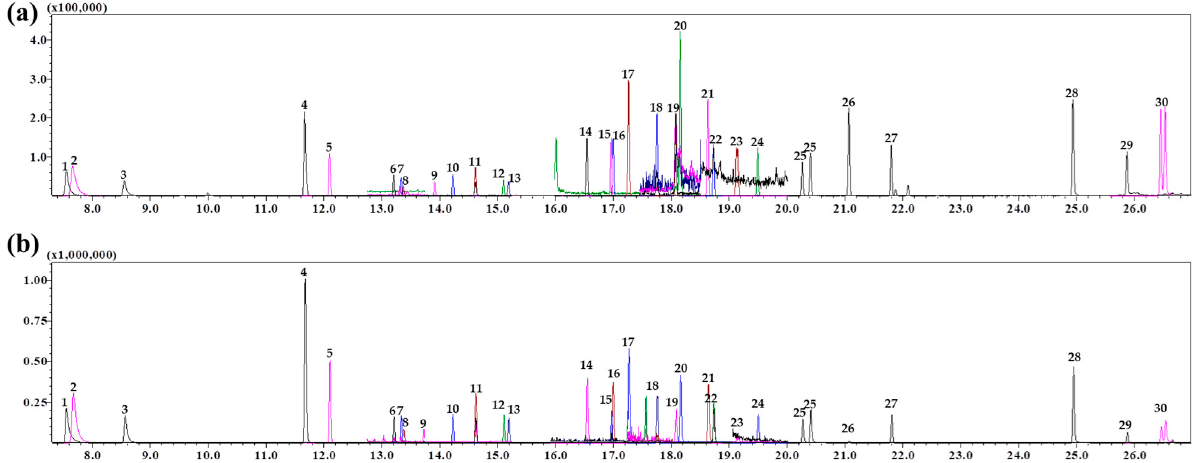
Figure 1. Comparison between split and splitless injections based on peak height and sensitivity for the different scale (10 folds) in GC-MS/MS. ( a ) Total ion chromatogram (ratio 10) of pesticides standard mixture (50 ng/mL), which was obtained using the split injection method; ( b ) Total ion